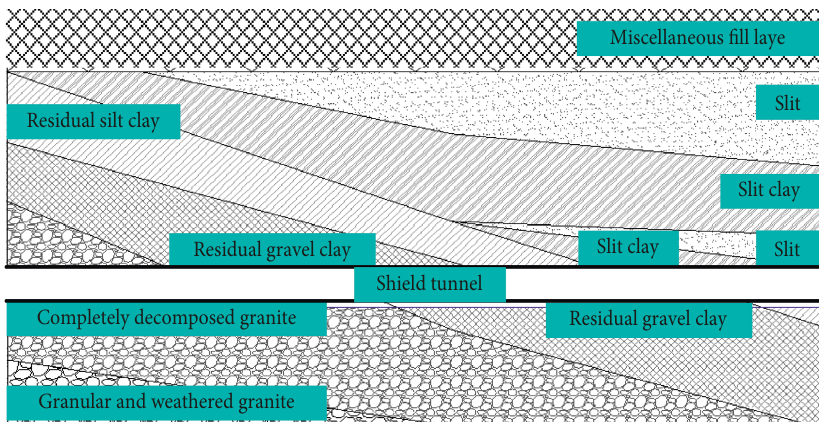
Figure 1: Cross section formation condition.